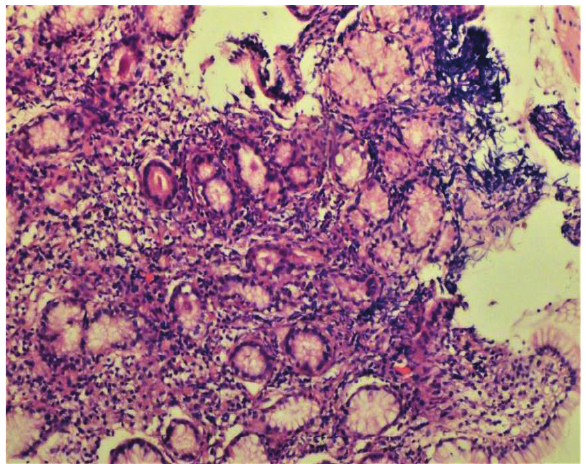
Fig-5: H&E Chronic marked antral gastritis